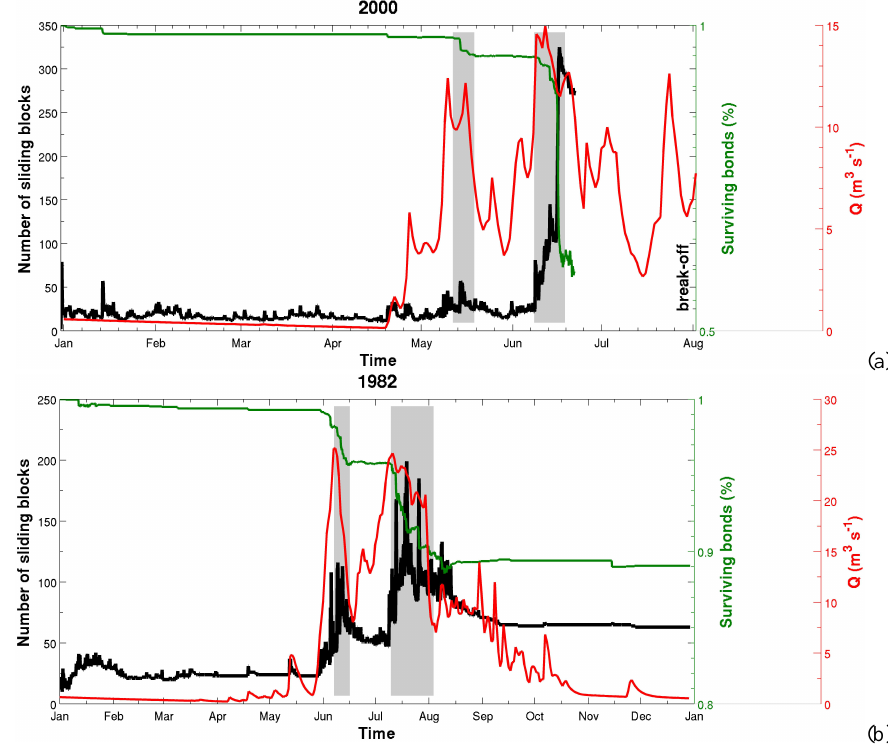
Fig. 12. Runoff, number of sliding blocks and surviving bonds as a function of time for the situation in 2000 (a) and 1982 (b) . Gray zones indicate periods during which intensive fragmentation